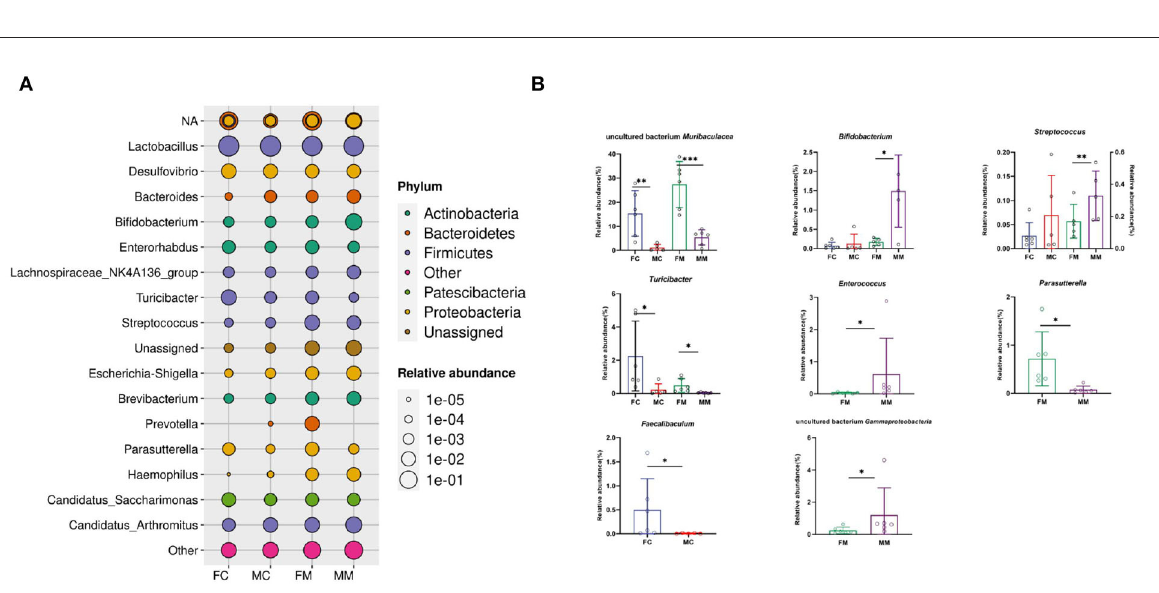
attributed to the fact that MAM is less affected by food rather than LM. Zhang C. et al. (2021) proved that MAM is more susceptible to repeated stress-related diarrhea in